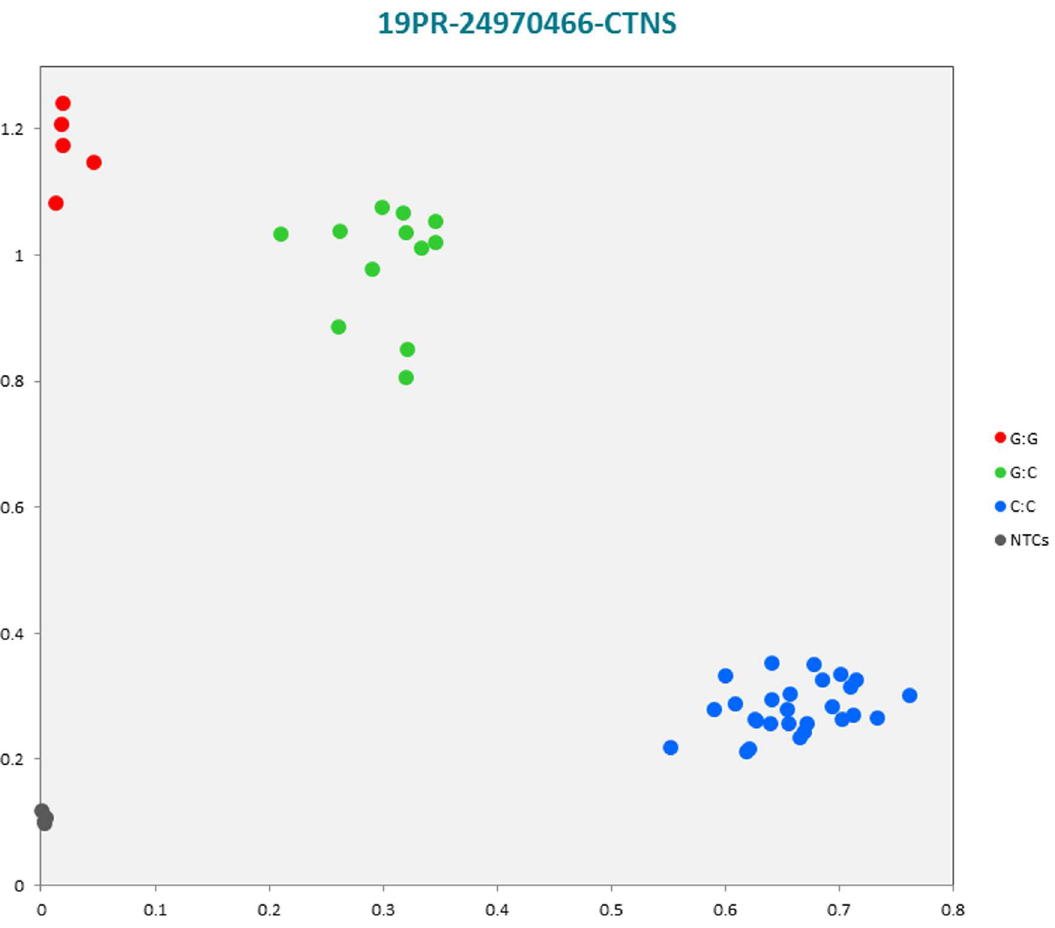
Fig 3. KASP TM SNP genotyping assay of BTA19_24970466locus of Polish Red CTNS gene showing the data for single KASP TM assayson a single cluster